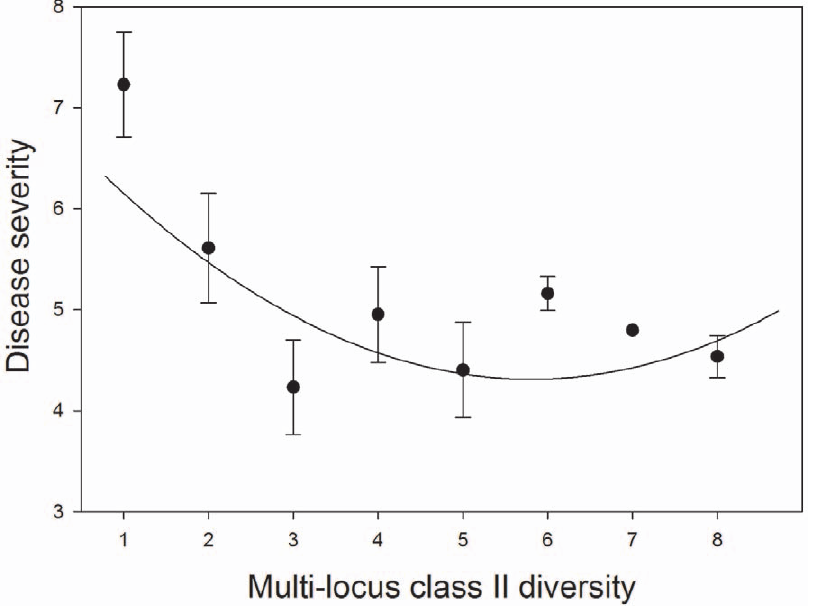
Figure 1. Multi-locus class II major histocompatibility complex (MHC) diversity and house finch disease resistance. MHC class II diversity as measured by single strand nuclear polymorphism predicts the severity of house finch ( Carpodacus mexicanus ) conjunctivitis in response to experimental infection with Mycoplasma gallisepticum (MG). All bars indicate one standard error around the mean.